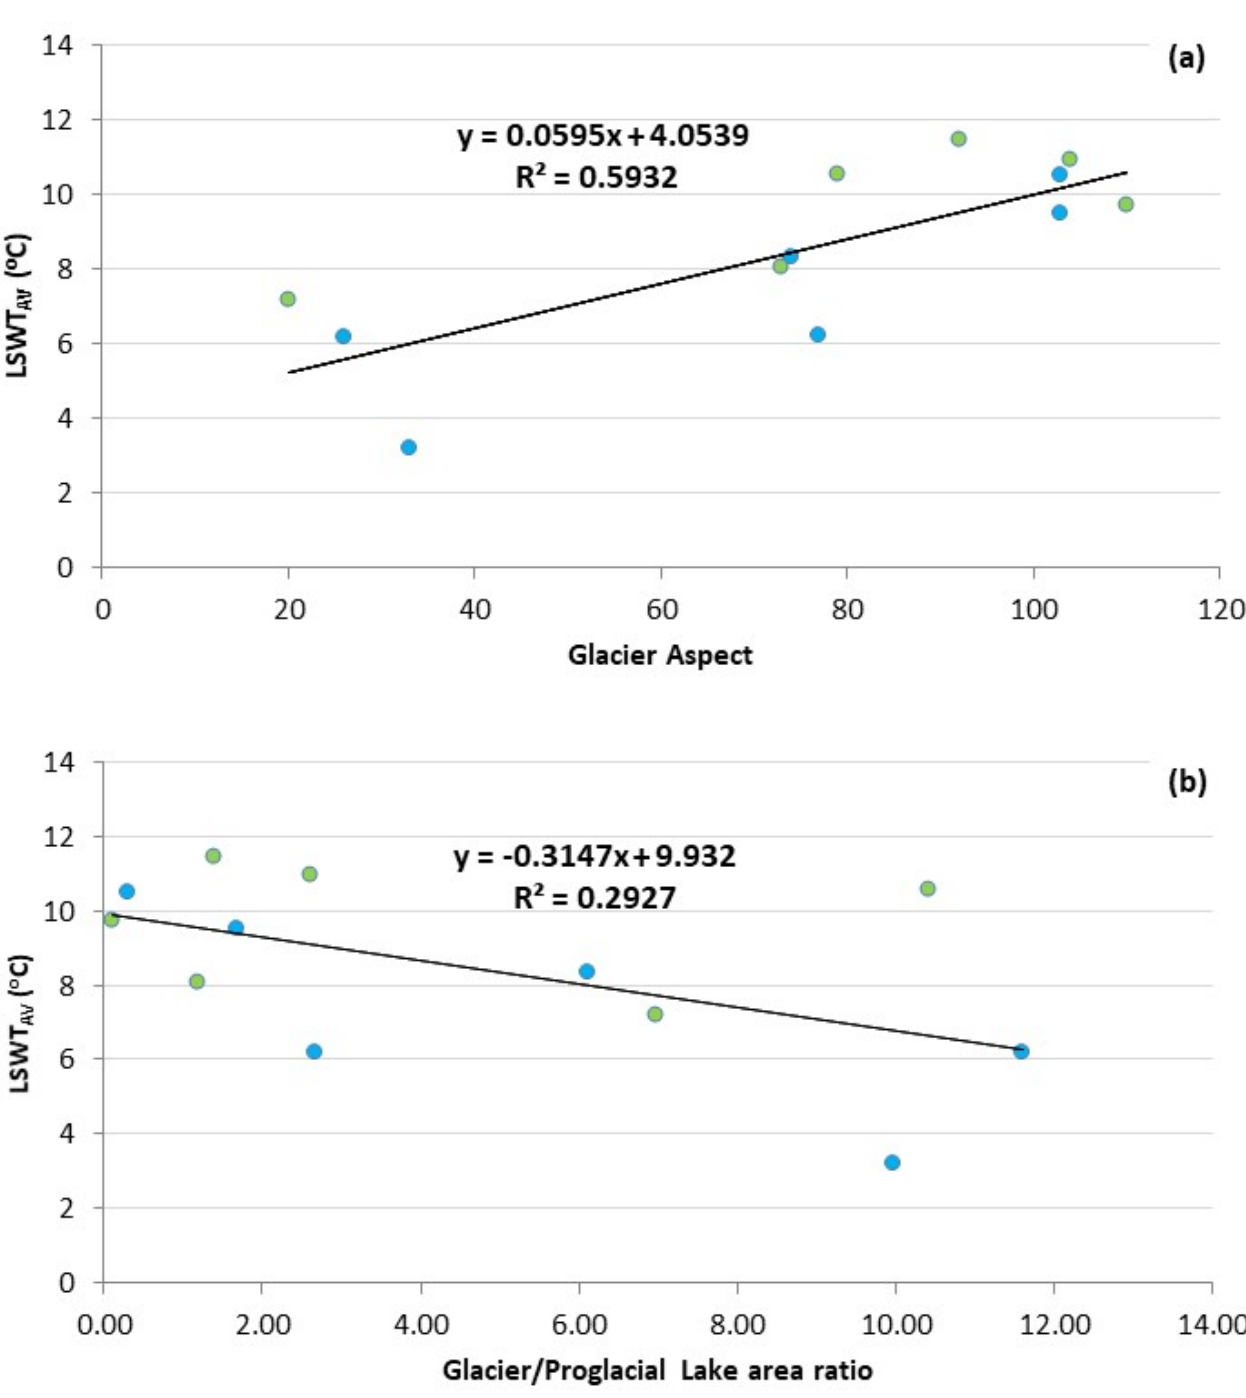
Figure 5. ( a ) Plot of average surface temperature (LSWT AV ) for each proglacial lake from AST08 analysis (8 August 2014) against the aspect of the parent glacier (RGI) [48]. ( b ) Plot of average surface temperature (LSWT AV ) for each proglacial lake from AST08 analysis (8 August 2014) against the ratio of parent glacier (RGI)/proglacial lake area [48]. Blue data points denote ice-contact proglacial lakes. Green data points denote non-ice-contact proglacial lakes. The temperatures described above were extracted from both ice-contact proglacial lakes and non-ice-contact proglacial lakes. The sample presented here included six ice- contact proglacial lakes (AST08 ID lakes 1, 3, 4, 6, 11, 12) and six non-ice-contact proglacial